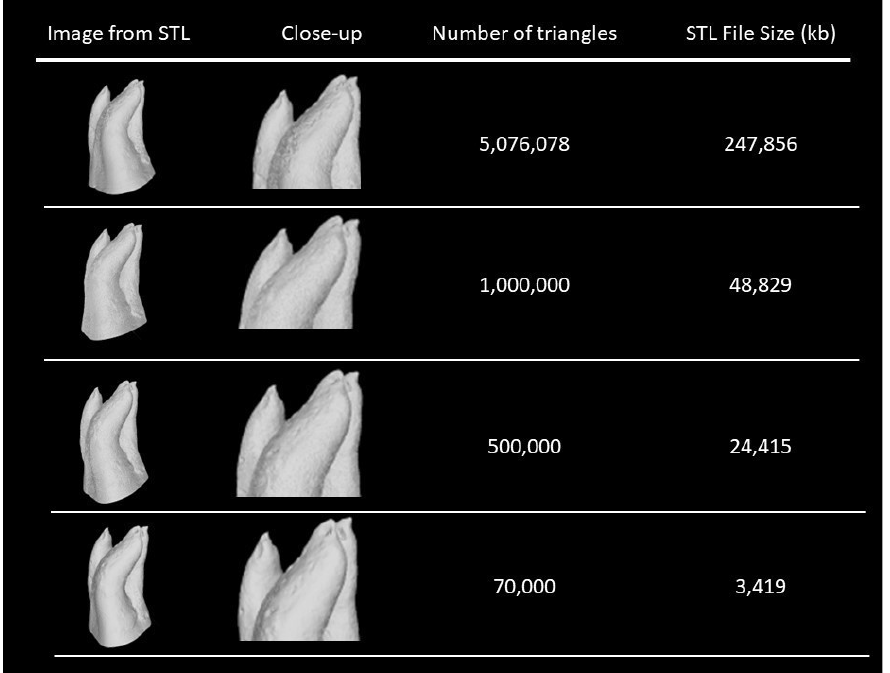
Figure 2. Differences between the number of triangles and size in kilobytes (Kb) of Standard Tessellation Language (STL) files of the same maxillary first molar.